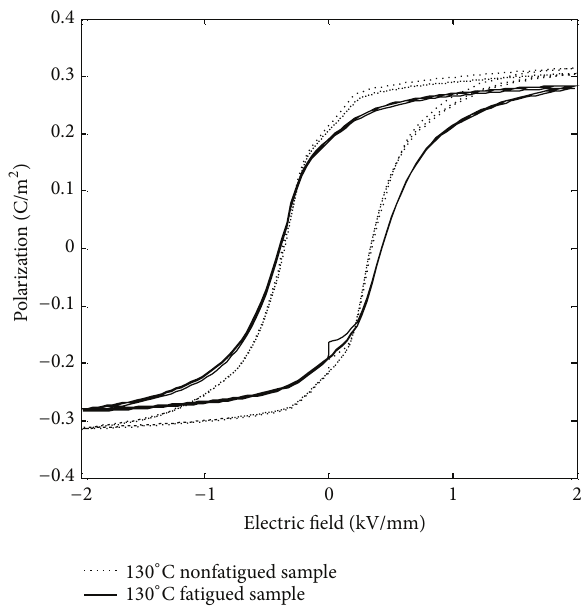
Figure 1: Comparison of dynamic hysteresis loops (polarization- electric field) before (pointed line) and after the fatigue occurrence (continuous line, 600th